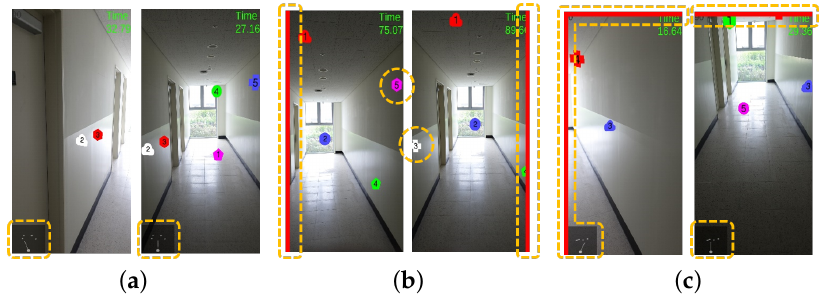
Figure 11. Examples of game guidance: ( a ) Radar guide: A screen where the location of a virtual object is provided as a mini-map based on the location of the user’s mobile device (marked on figure). ( b ) Navigation bar guide: A case where the objects are located on the top and right of the screen with bars in different colors based on the location of the user’s mobile device (marked on figure). ( c ) Integration with radar and navigation bar guide: A case where the radar and the navigation bar are provided together (marked on